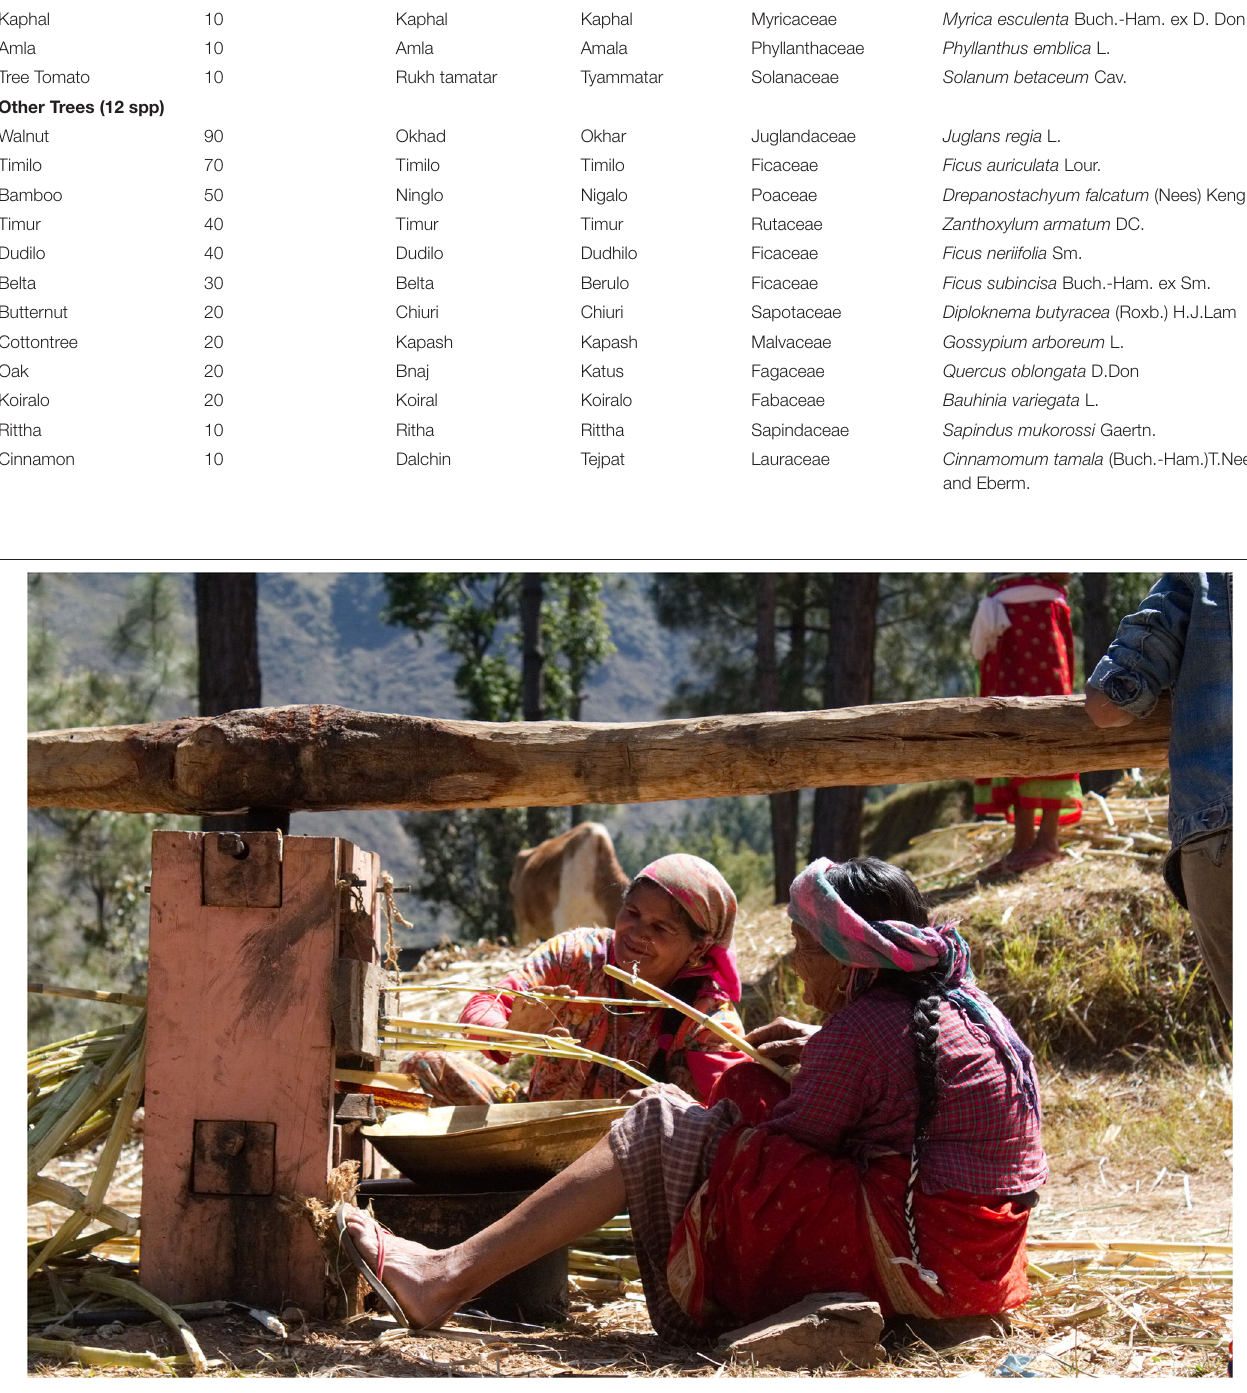
FIGURE 6 | Women feeding sugarcane into a gur